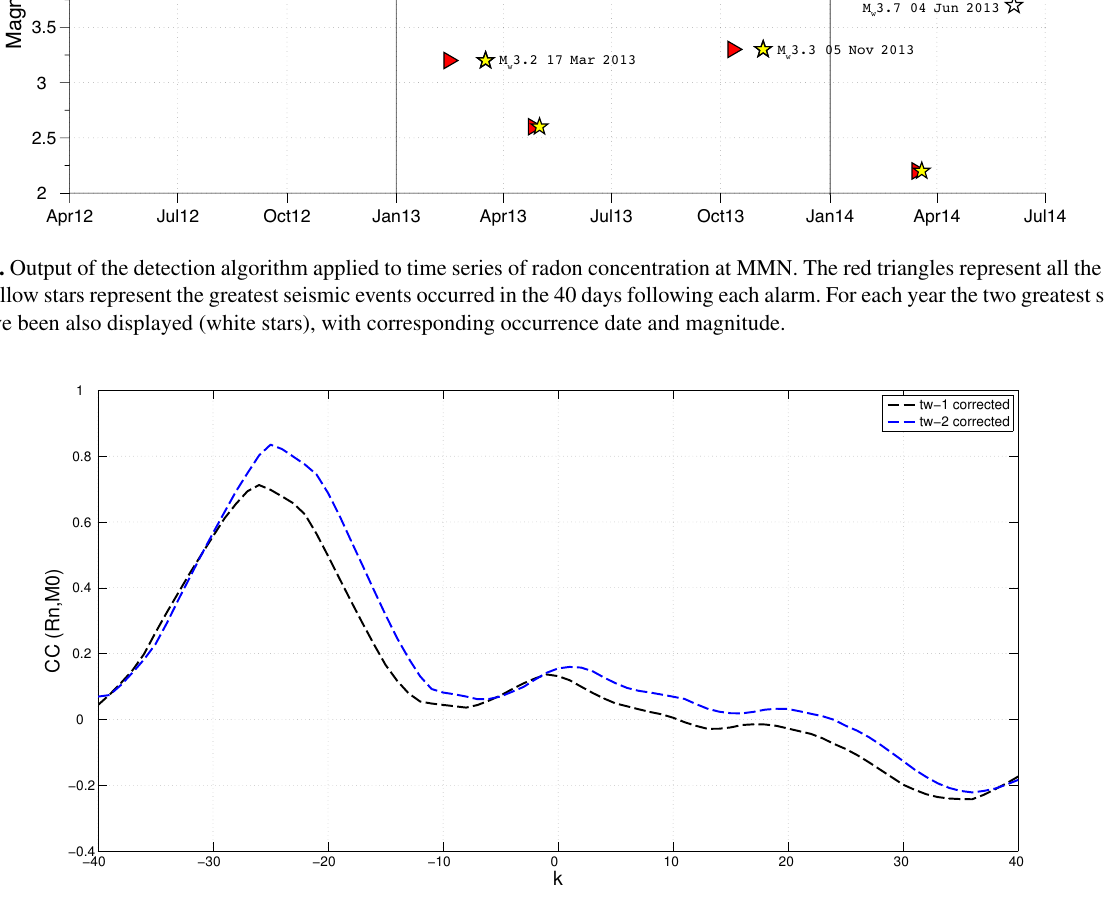
Figure 12. The same as Fig. 7, but limiting the search domain of MINUIT only to positive lag values ( k ) (the corresponding correction coefficients are reported in Table